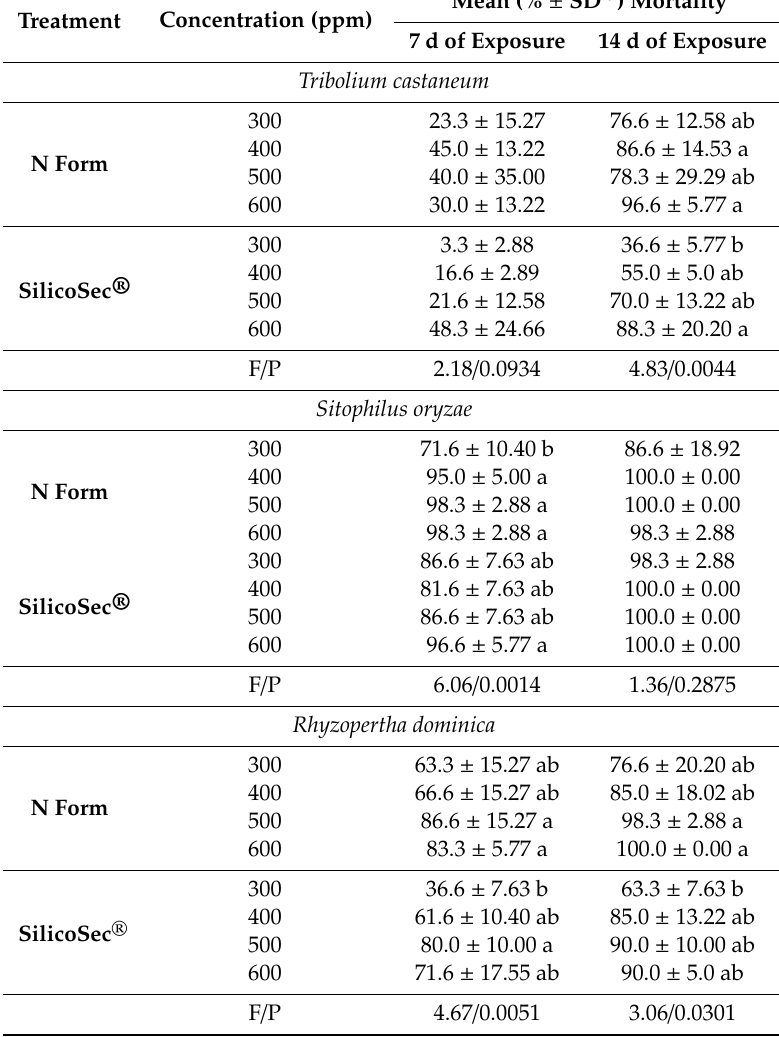
Table 1. Mean (% ± SD) mortality of Tribolium castaneum, Sitophilus oryzae, and Rhyzopertha dominica adults after 7 and 14 d of exposure to treated wheat seeds with formulation N Form and DE SilicoSec ®